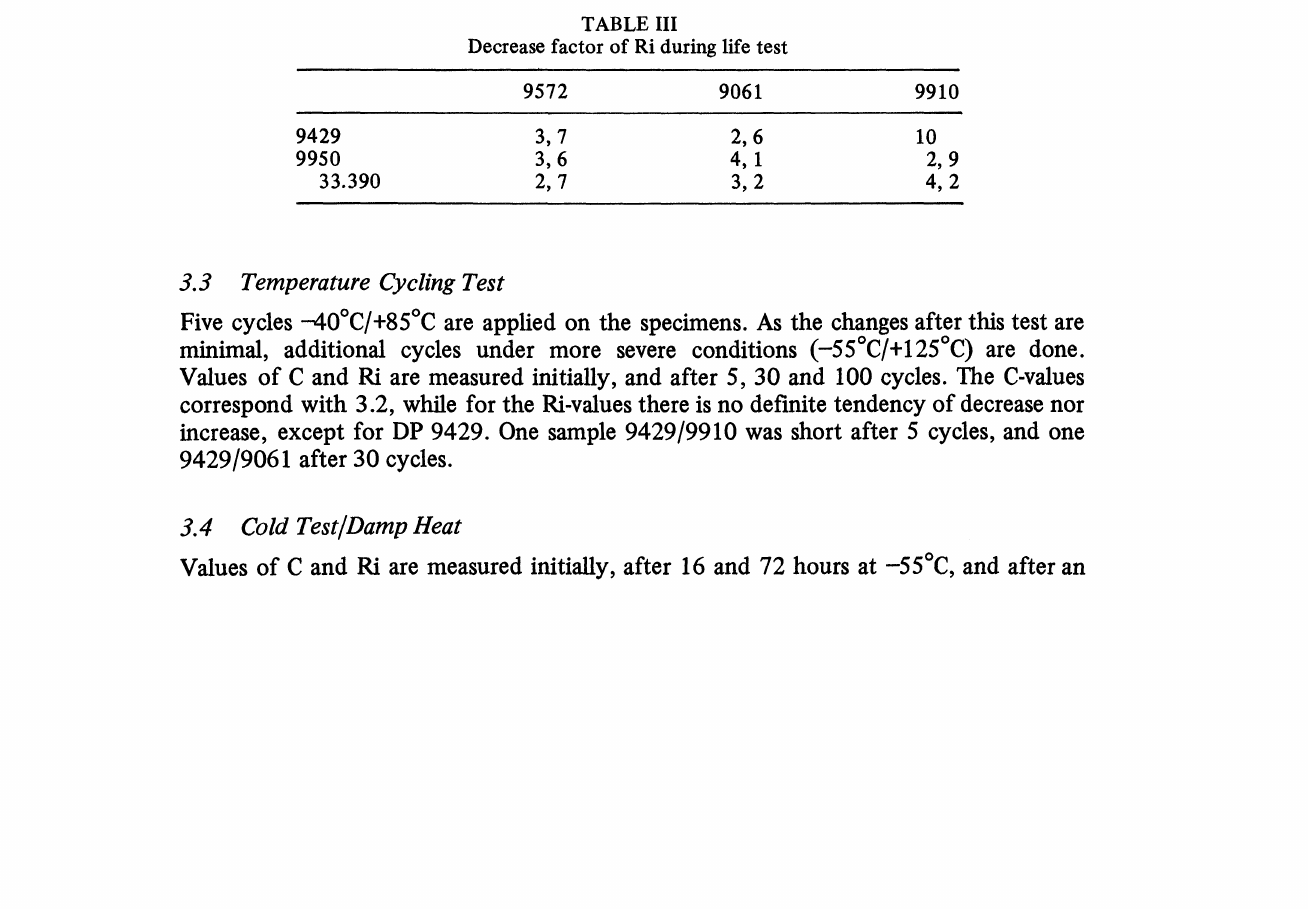
TABLE II Average C-values of the 9 combinations (in